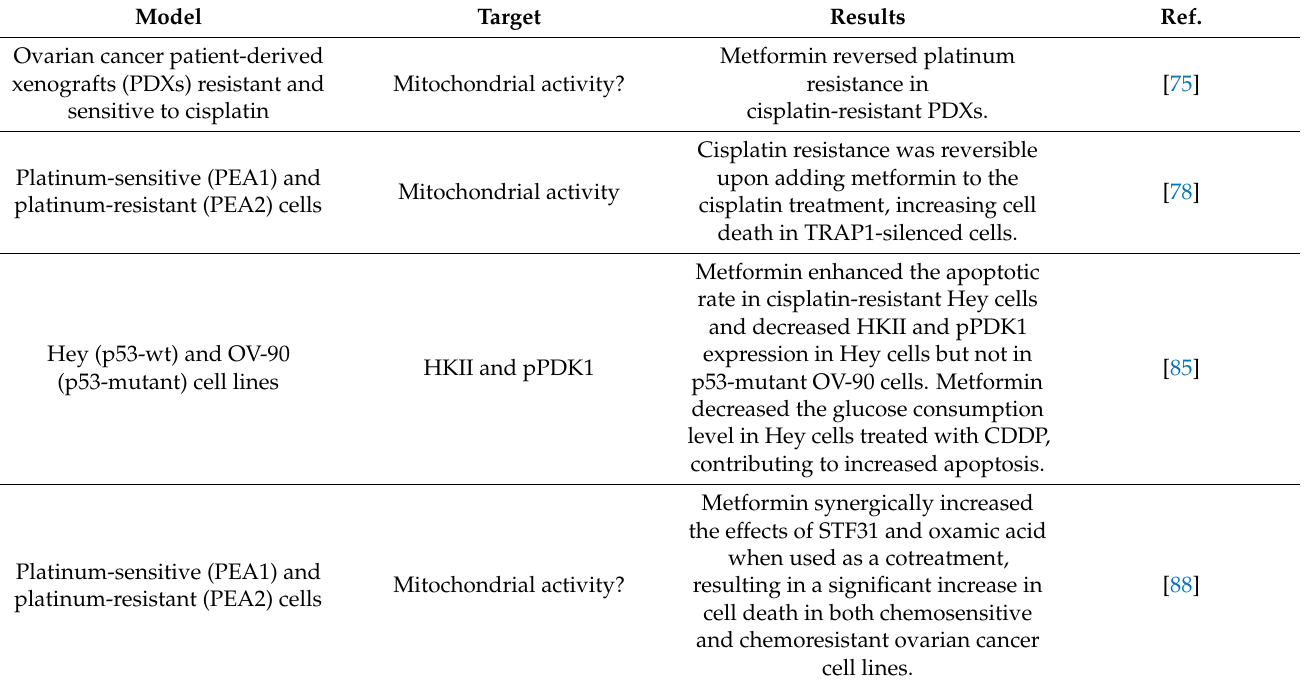
Table 2. Studies investigating metformin as a metabolic